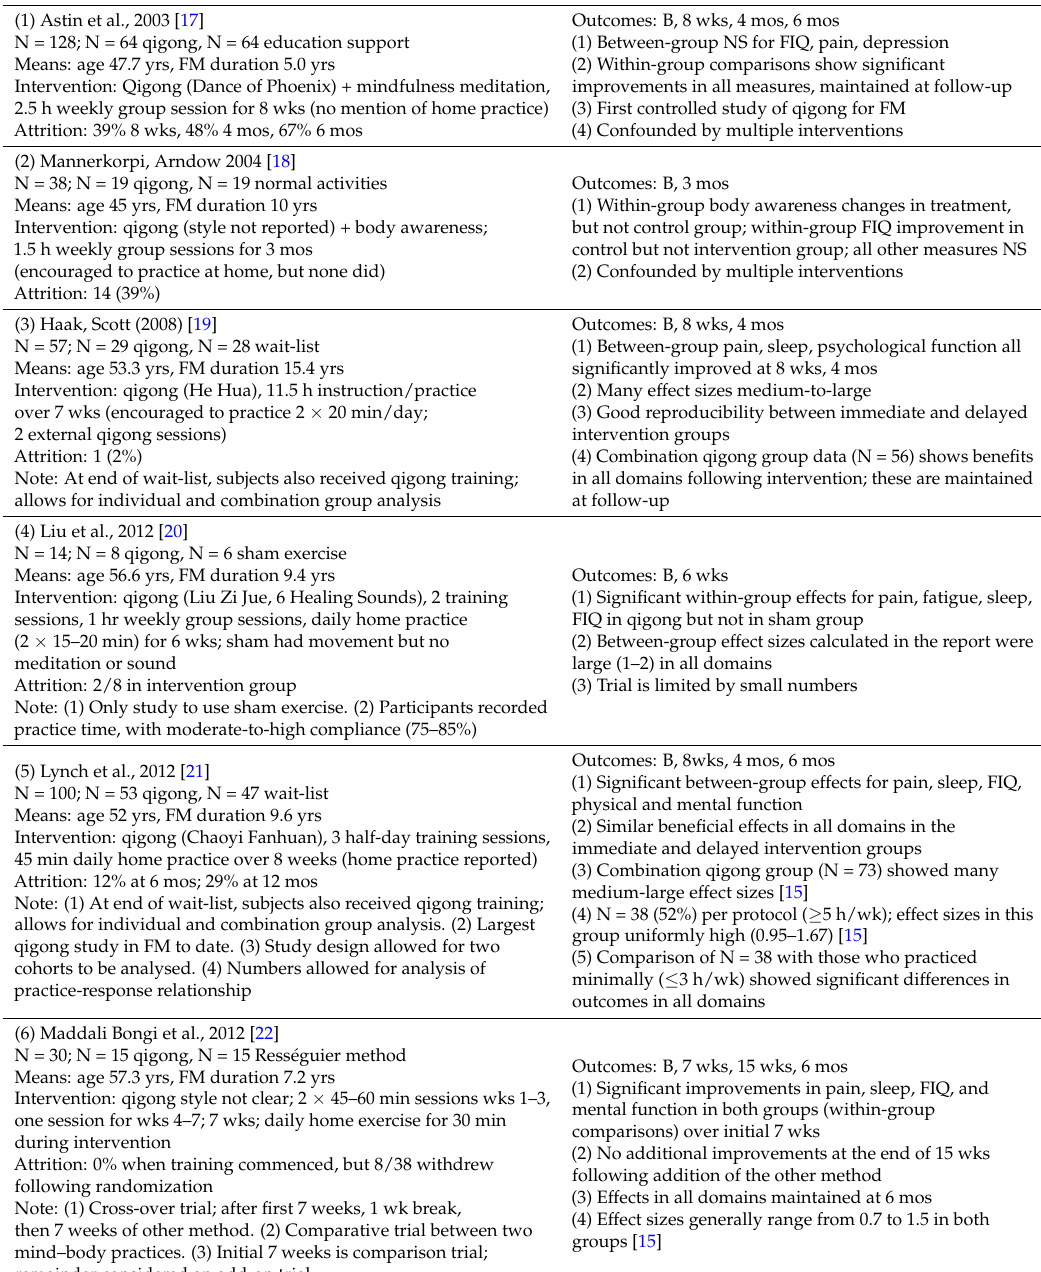
Table 2. Summary of randomized controlled trials (RCTs) of qigong for fibromyalgia in adults. Study Characteristics Outcomes,